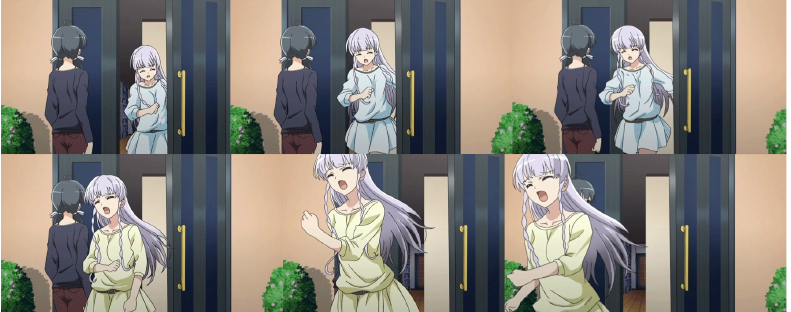
Figure 2. The same character in a sequence is mis-colored from bluish clothes to yellow